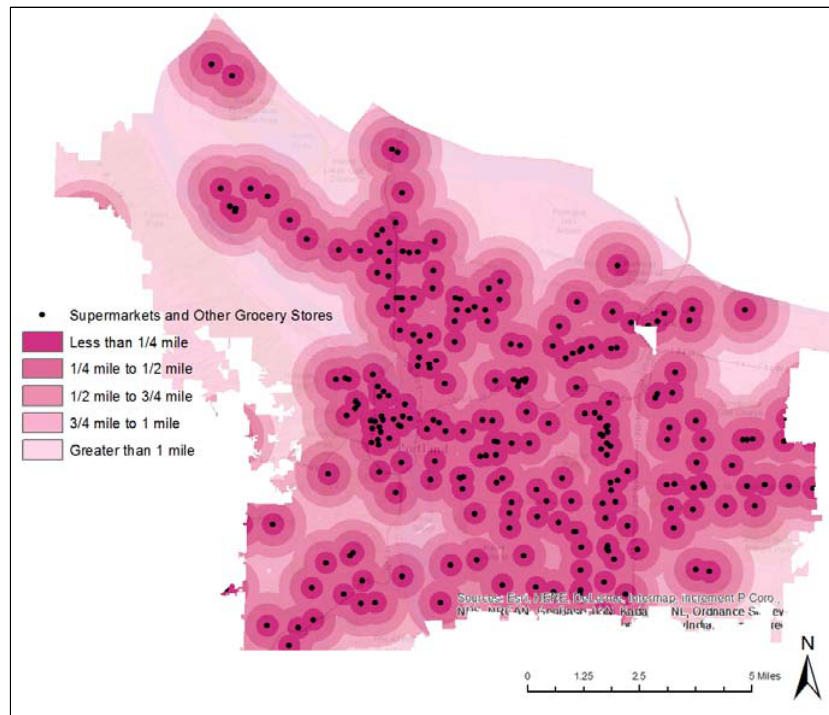
Figure 8. Proximity to Supermarkets and Other Grocery Stores